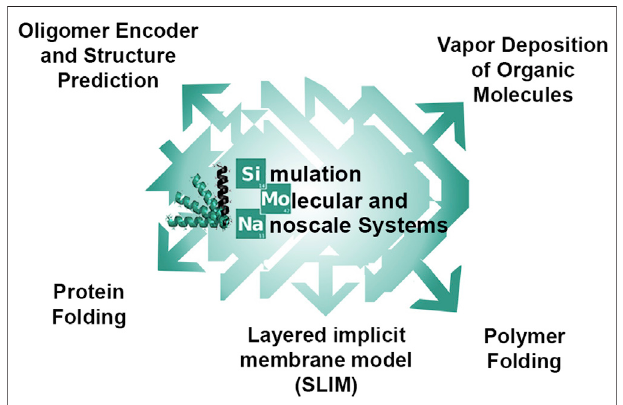
FIGURE 1 | Possible applications of SIMONA described in this